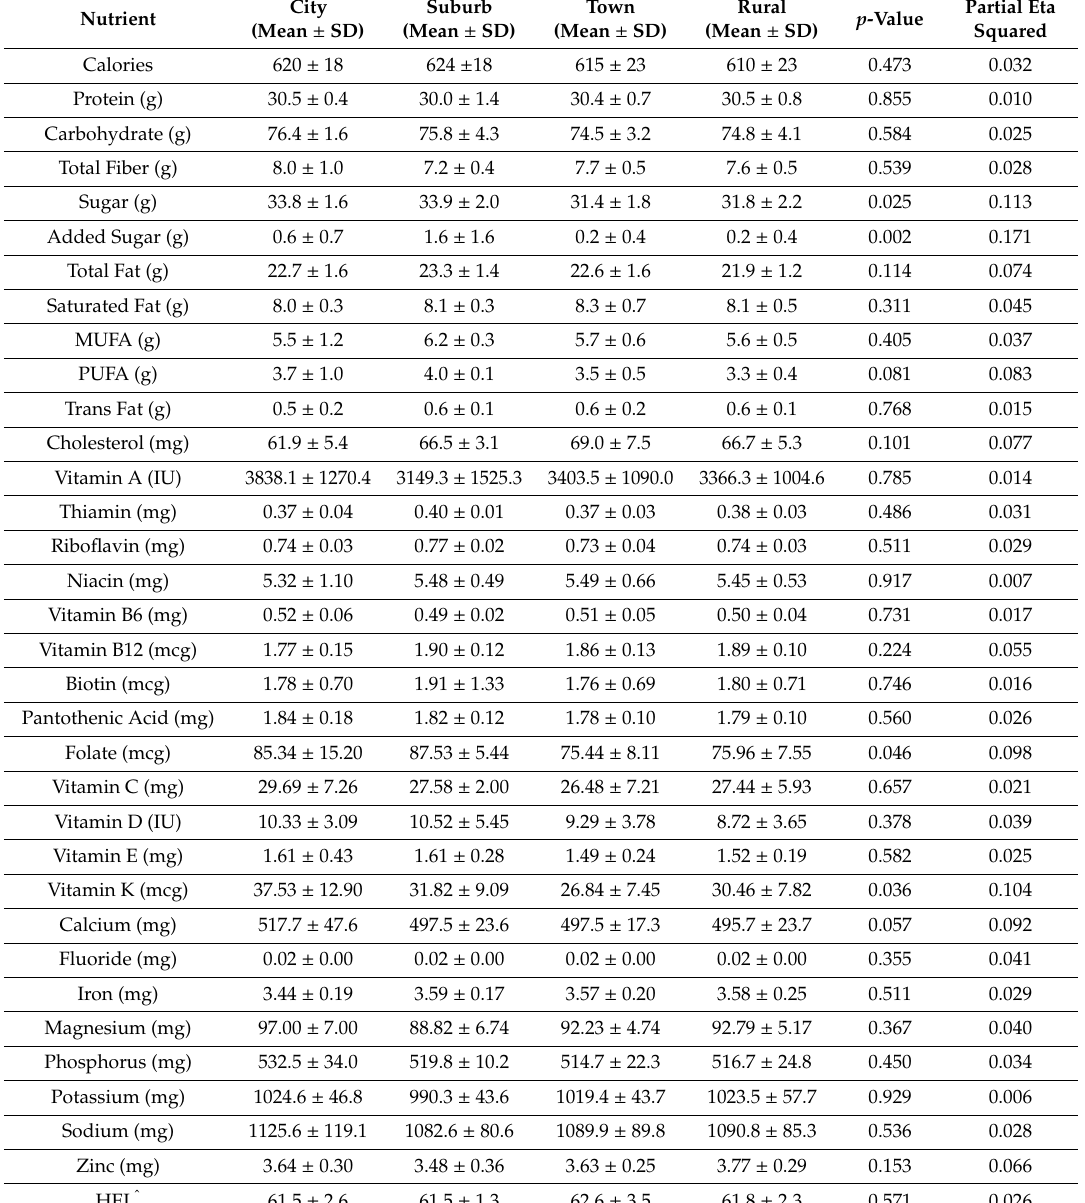
Table 2. Comparison of nutrient content and DQ by